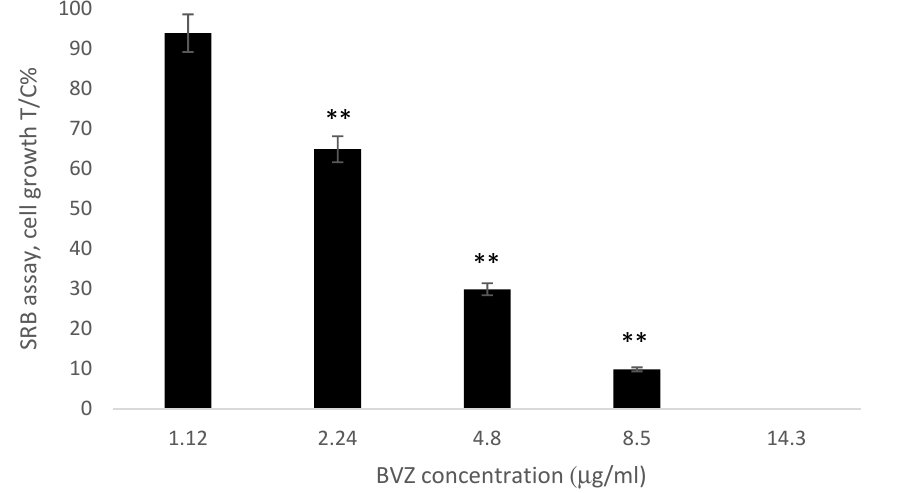
Figure 6. Effect of BVZ on ARPE-19 cell proliferation after 48 h of incubation. Cell growth is expressed as% T/C (mean optical density (OD) of treated cells/mean OD of control cells × 100). Values are mean ± SD (n = 3 wells/condition) of three independent experiments (** p < 0.01).